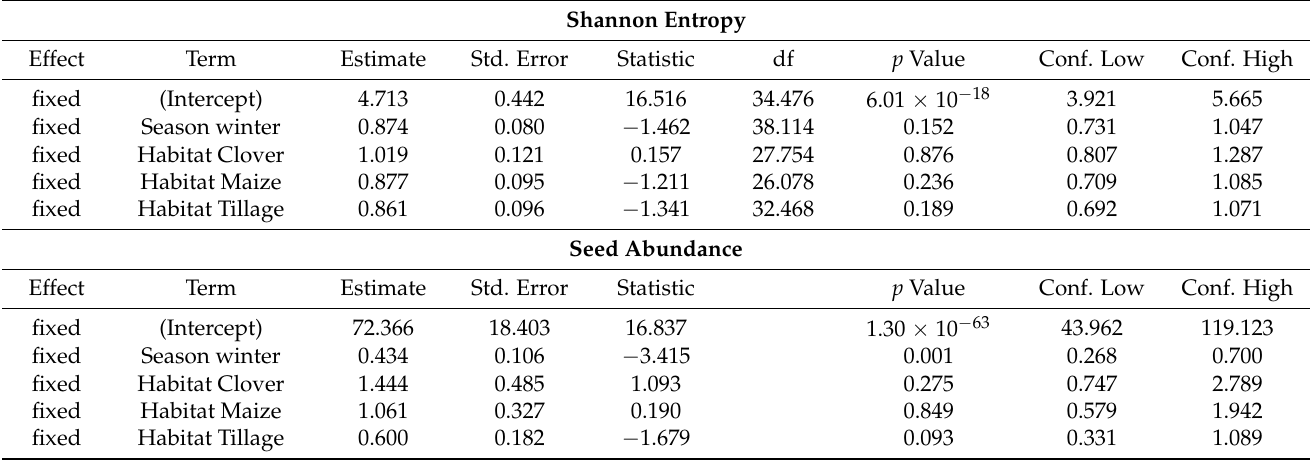
Table 3. Model summary for Shannon entropy and seed abundance.